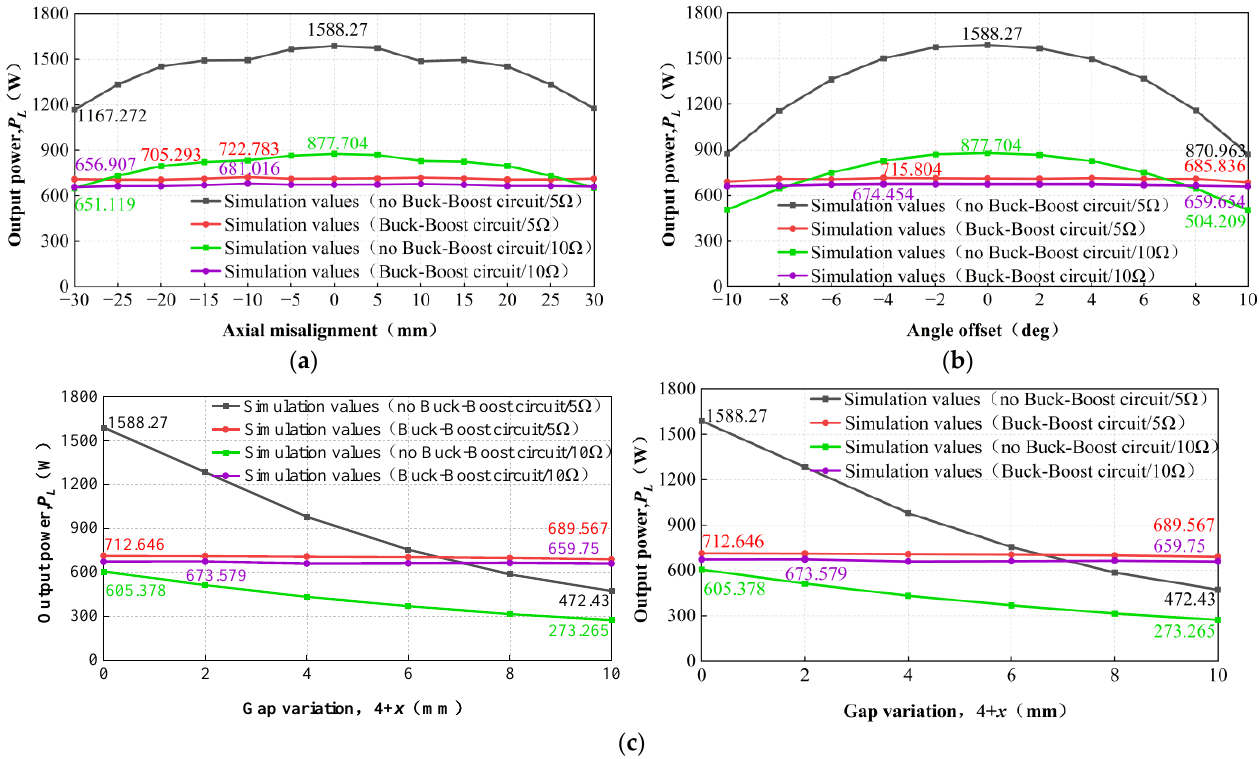
Figure 17. Power control curve for axial, angle, and gap offset. ( a ) Axial misalignment; ( b ) Angle offset; ( c ) Gap variation.